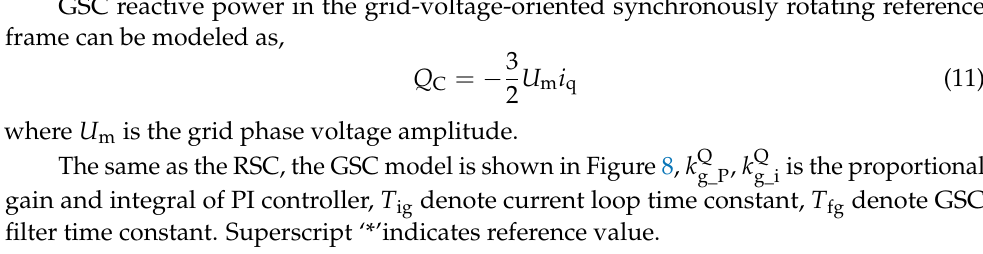
Figure 7. The GSC control block diagram.